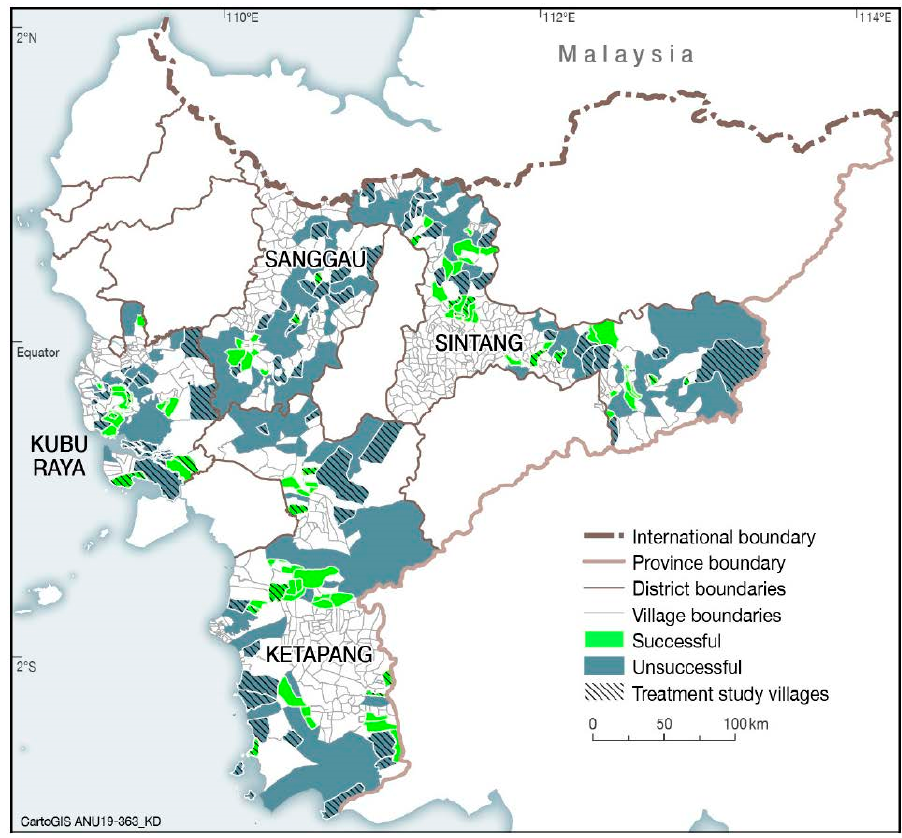
Figure 4. Locations of Successful and Unsuccessful Villages.